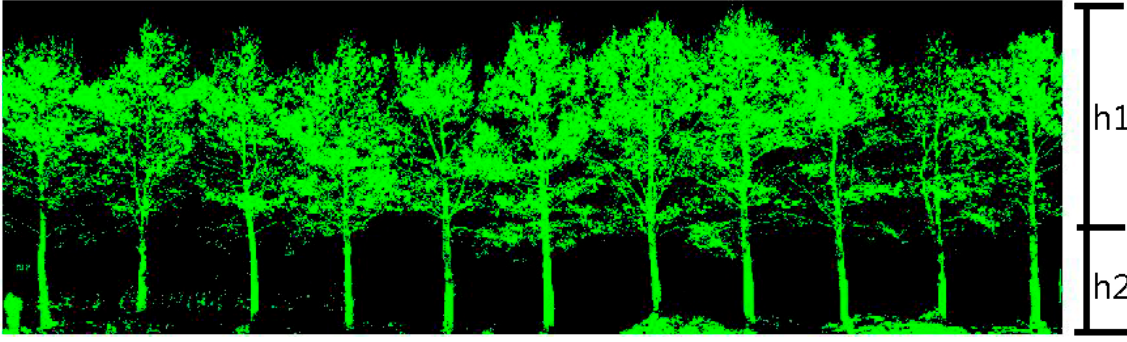
Figure 3. Extraction chart of the porosity.